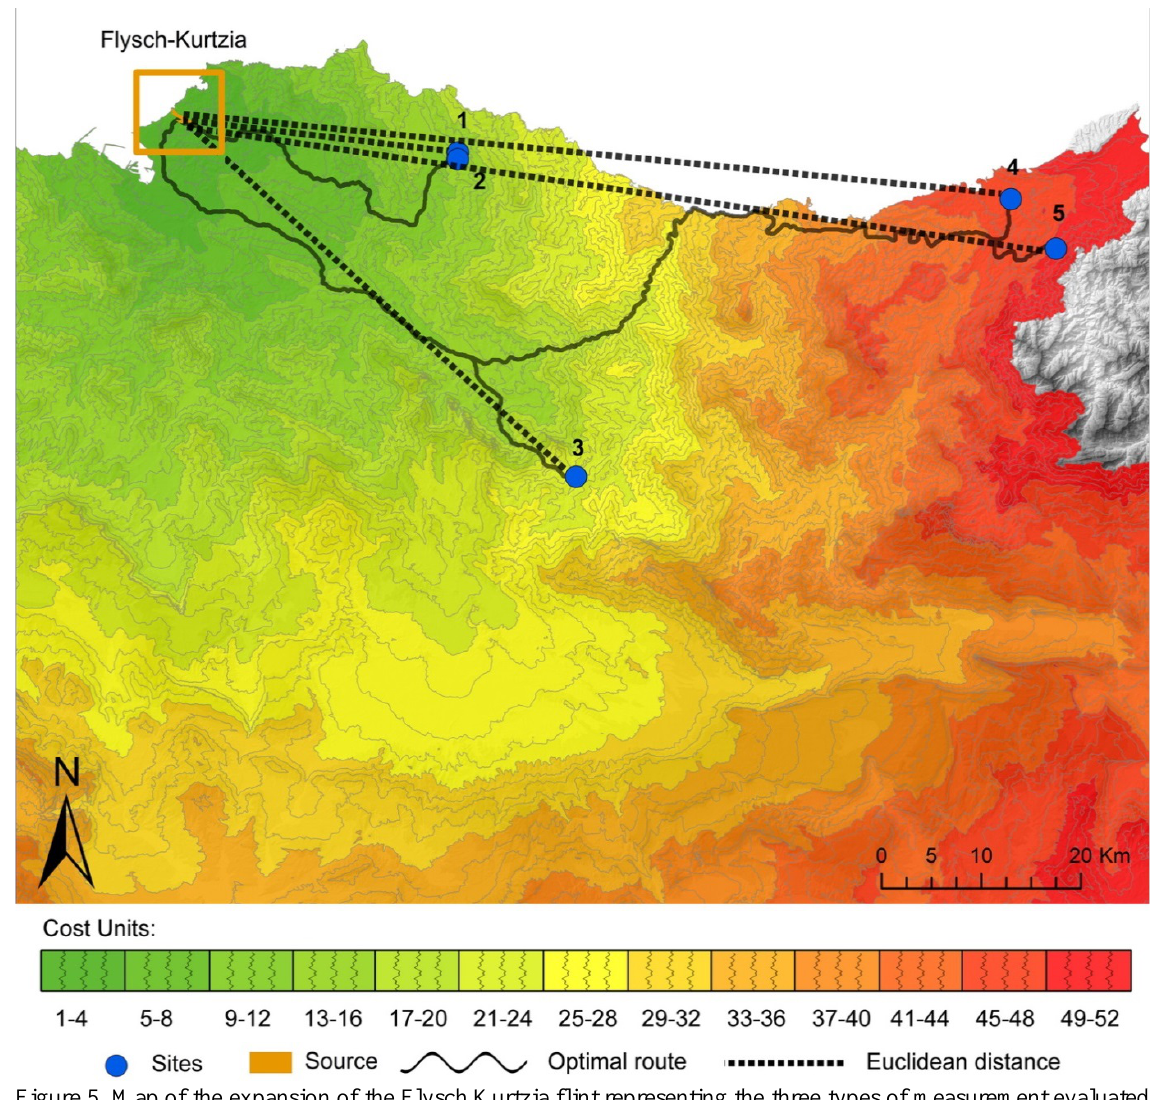
Figure 5. Map of the expansion of the Flysch Kurtzia flint representing the three types of measurement evaluated in this paper: Euclidean distance, the distance through the optimal route and cost. Legend: 1. Antoliñako Koba, 2. Santimamiñe, 3. Labeko Koba, 4. Ametzagaina and 5. Aitzbitarte